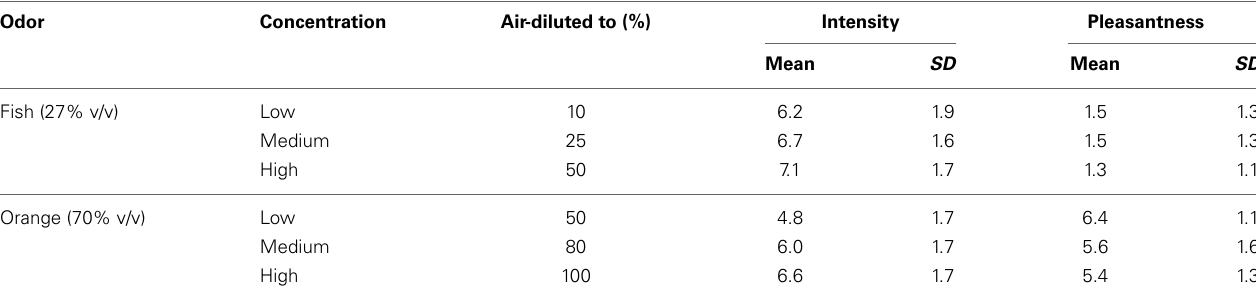
Table 1 | Average ratings (0 − 10, with standard deviation) of fish and orange odors diluted to different concentrations. Odor